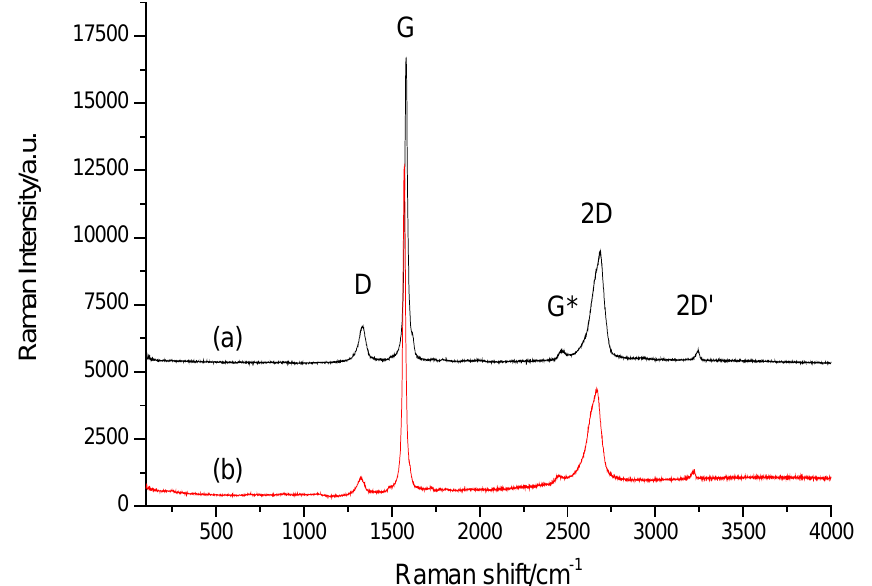
Figure 3. Raman spectra of the samples: ( a ) MLG, ( b ) GFs, recorded using the 623.8 nm He-Ne laser line. The characteristic D ( ≈ 1360 cm − 1 ), G ( ≈ 1560 cm − 1 ), 2D ( ≈ 2700 cm − 1 ), and 2D’ ( ≈ 3250 cm − 1 ) bands for polycarbonate specimens are marked.